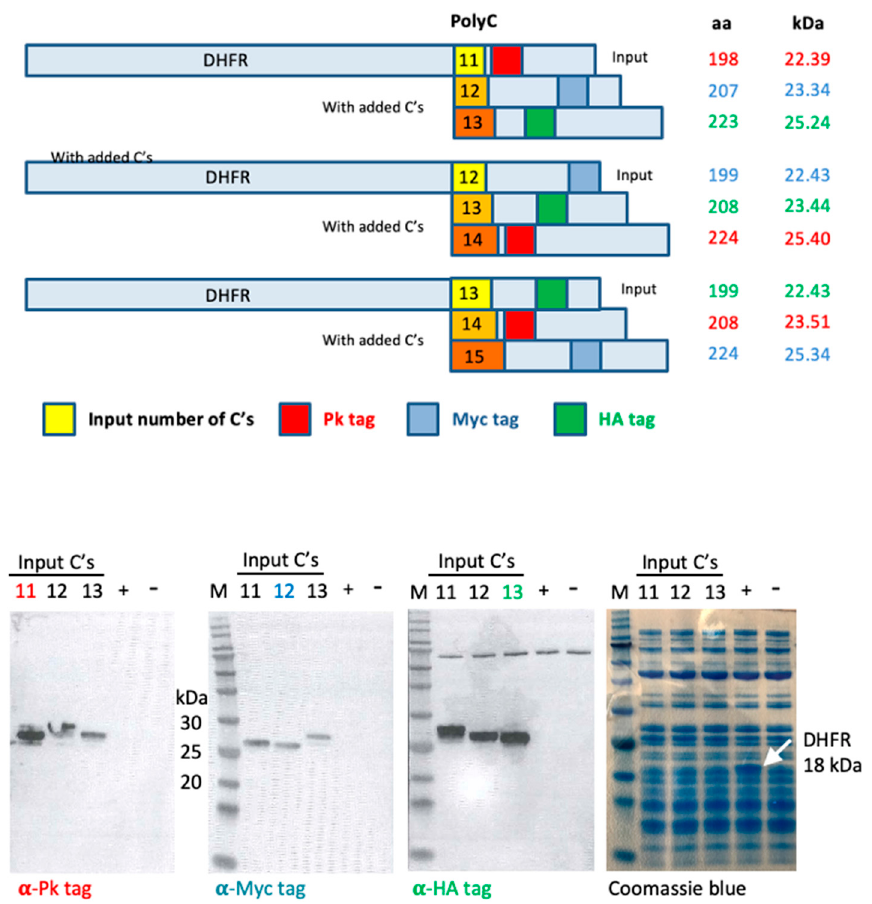
Figure 5. Slippage during a one ‐ step in vitro transcription/translation. (Top) A schematic representation of DHFR ORF coupled to 11, 12 or 13 homocytidine runs and mAb tags designated Pk (aka SV5), Myc and HA (influenza virus A hemagglutinin) in three reading frames. The amino acid lengths of the expressed proteins, as well as their estimated M r in kDa, are shown next to the schematics. The ORF nucleotide and predicted protein amino acid sequences are available in Figure S1. (Bottom) An in vitro T7 polymerase transcription/ E. coli translation reaction was conducted with each of the plasmid ORFs indicated above as the template, followed by a Western blot analysis of the three separately run reactions loaded next to each other. Three identical Western blot membranes were incubated, with individual tag ‐ specific mAbs indicated below, and a secondary